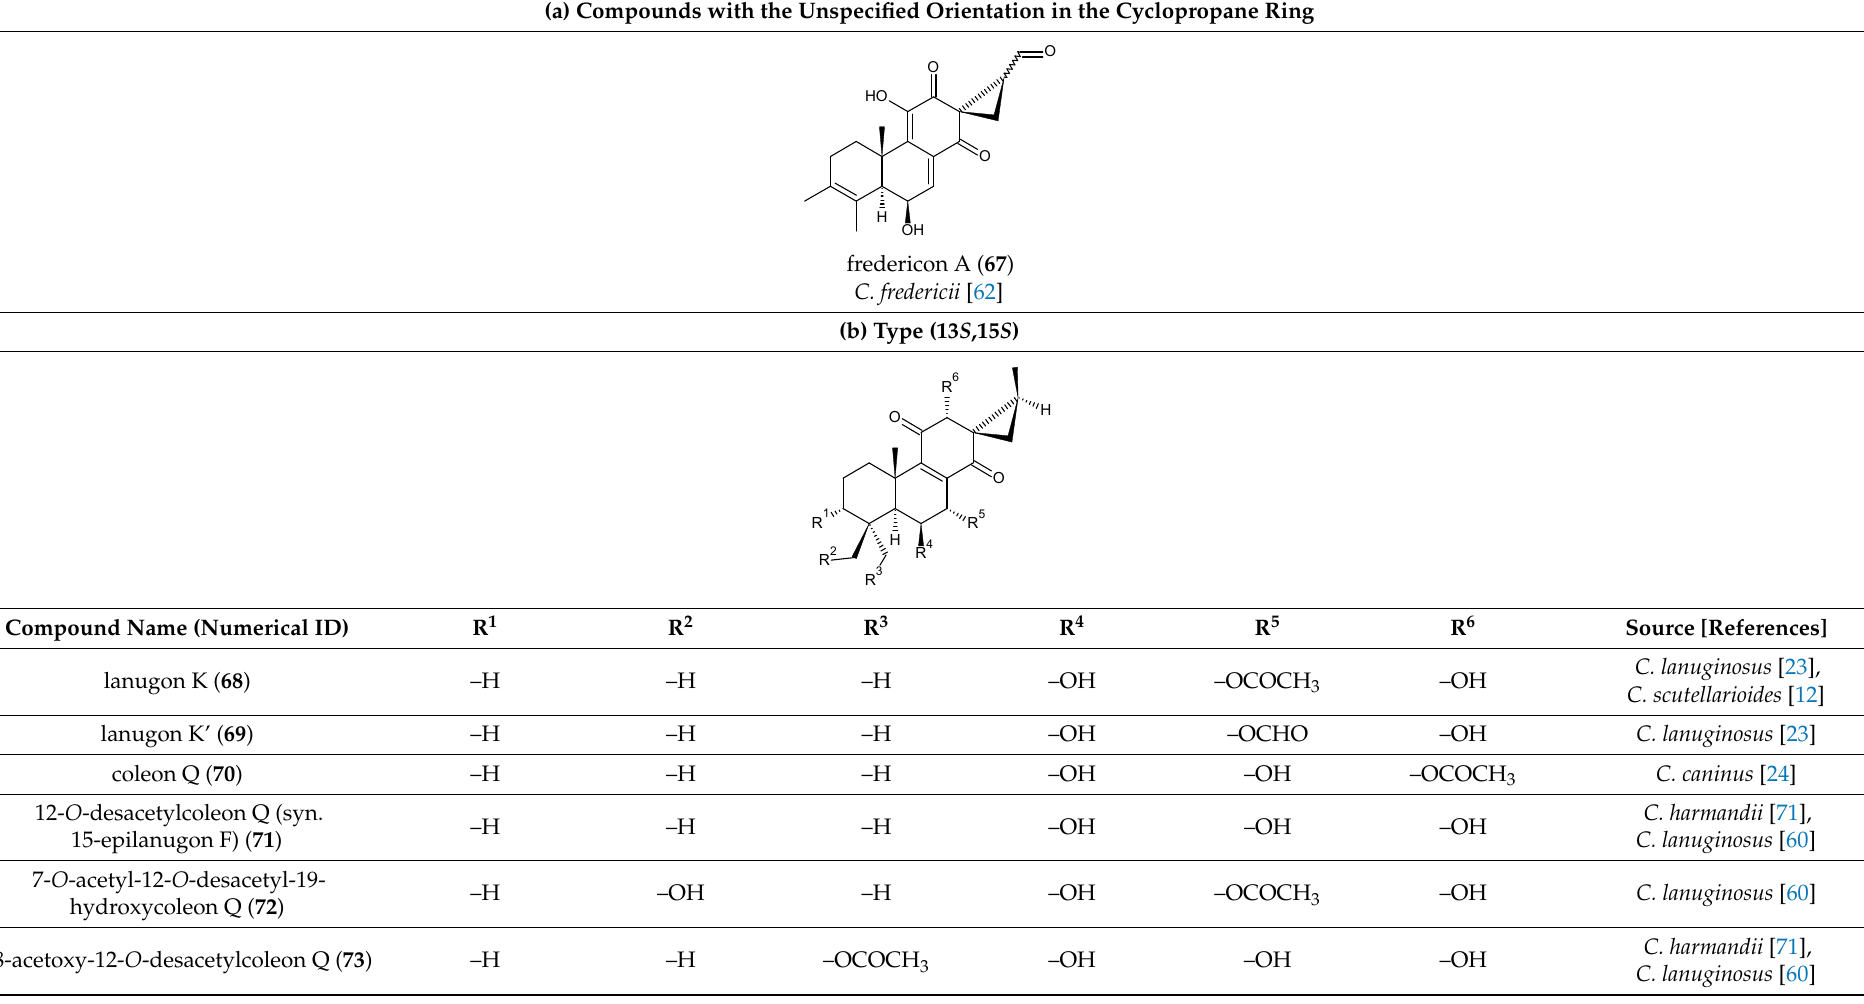
Table 2. Spirocoleons of the genus Plectranthus s.l.